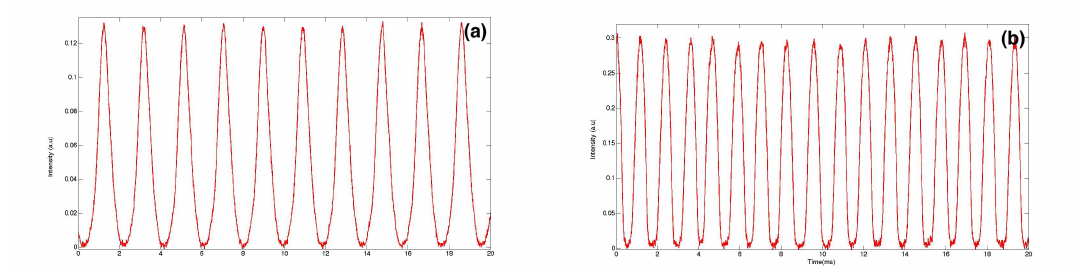
Figure 3. Fluorescence signal extracts from setup ( a ) without surfactant; ( b ) with